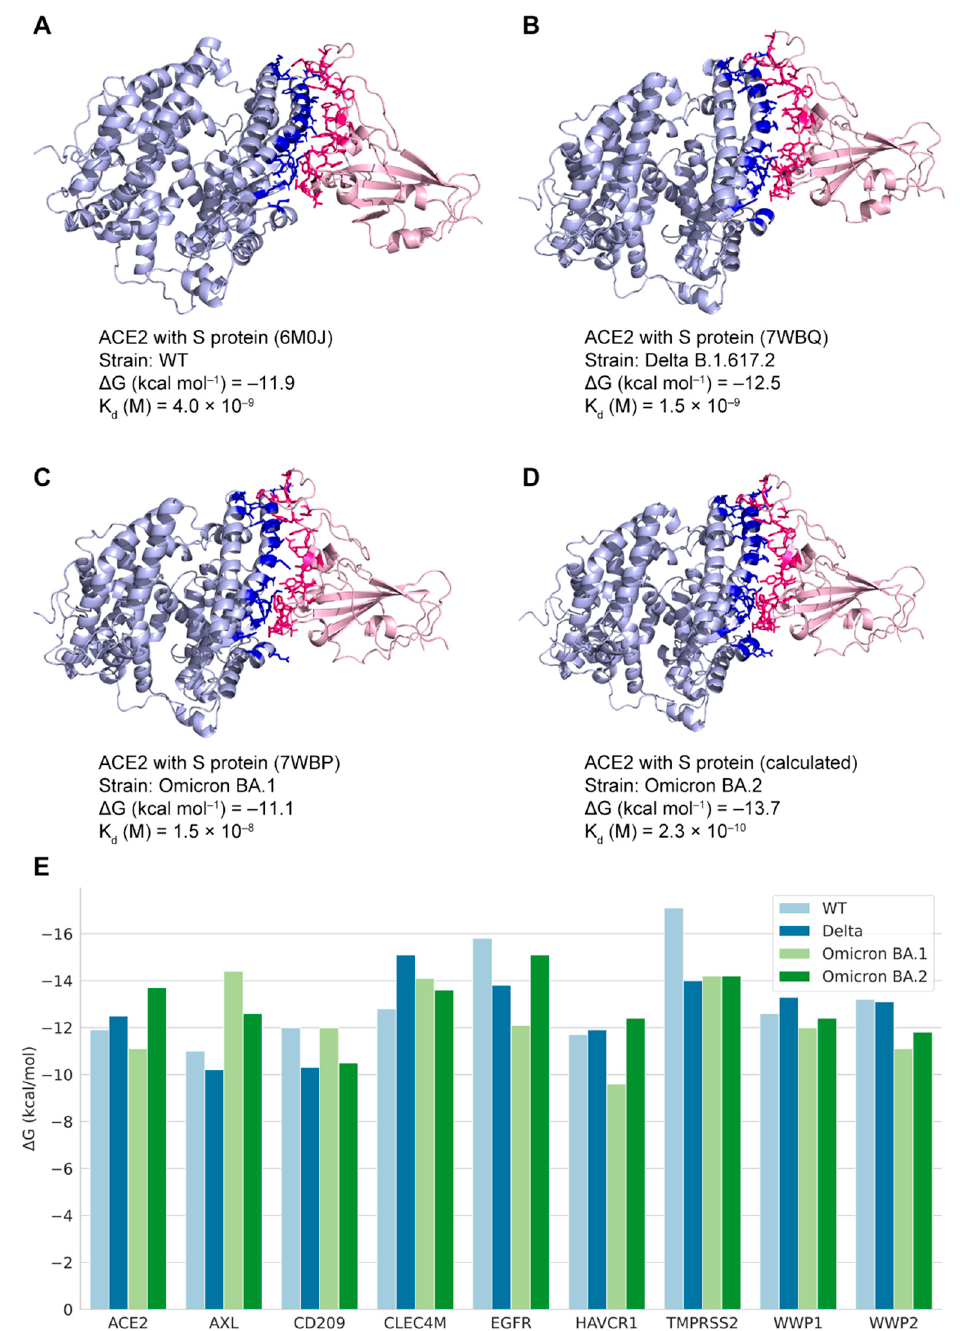
Figure 4. States of human proteins binding with SARS-CoV-2 variants S proteins. ( A – C ) Experimental structures of human ACE2 protein binding with S proteins (PDB ID: 6M0J, 7WBQ, and 7WBP); ( D ) Calculated docking structure of human ACE2 protein binding with Omicron BA.2 S protein. The docking temperature is 37 °C. The binding interfaces are highlighted in deep blue and pink colors; ( E ) The Δ G values represent free energy of human proteins binding with variants S proteins.